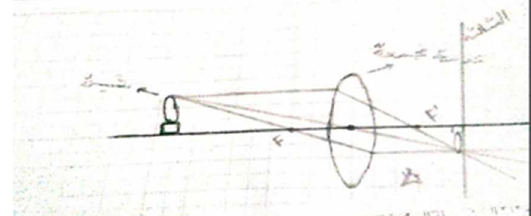
Figure .1 l’emplacement de l’œil de l’observateur, tracé par les élèves. Apres l’intervention, nous avons demandé aux élèves de répondre à même question, avec une explication. Voir schéma.2